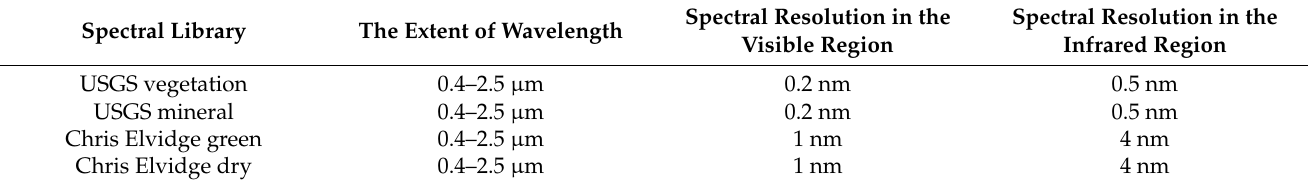
Table 2. The details of spectral